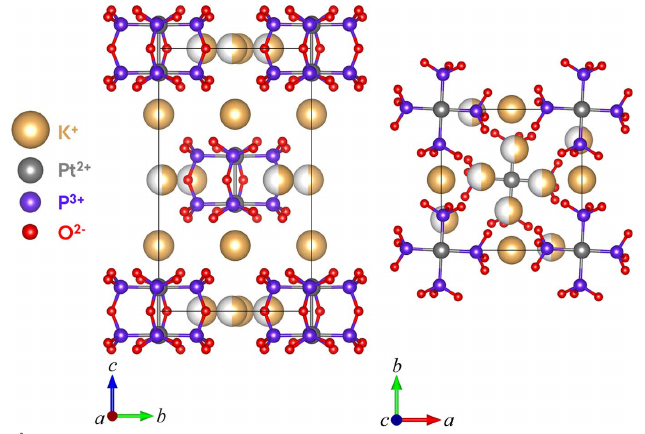
atoms have been